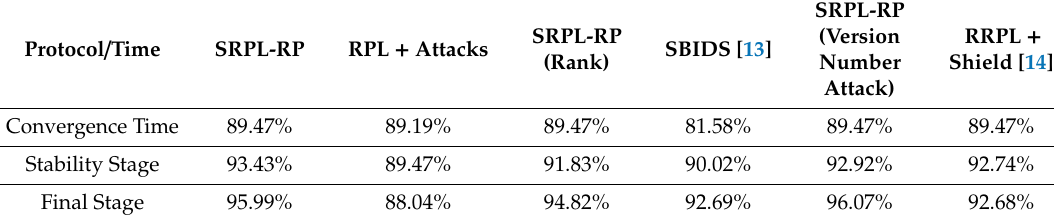
Table 4. Packet Delivery Ratio Comparison in Grid-Random Topology.